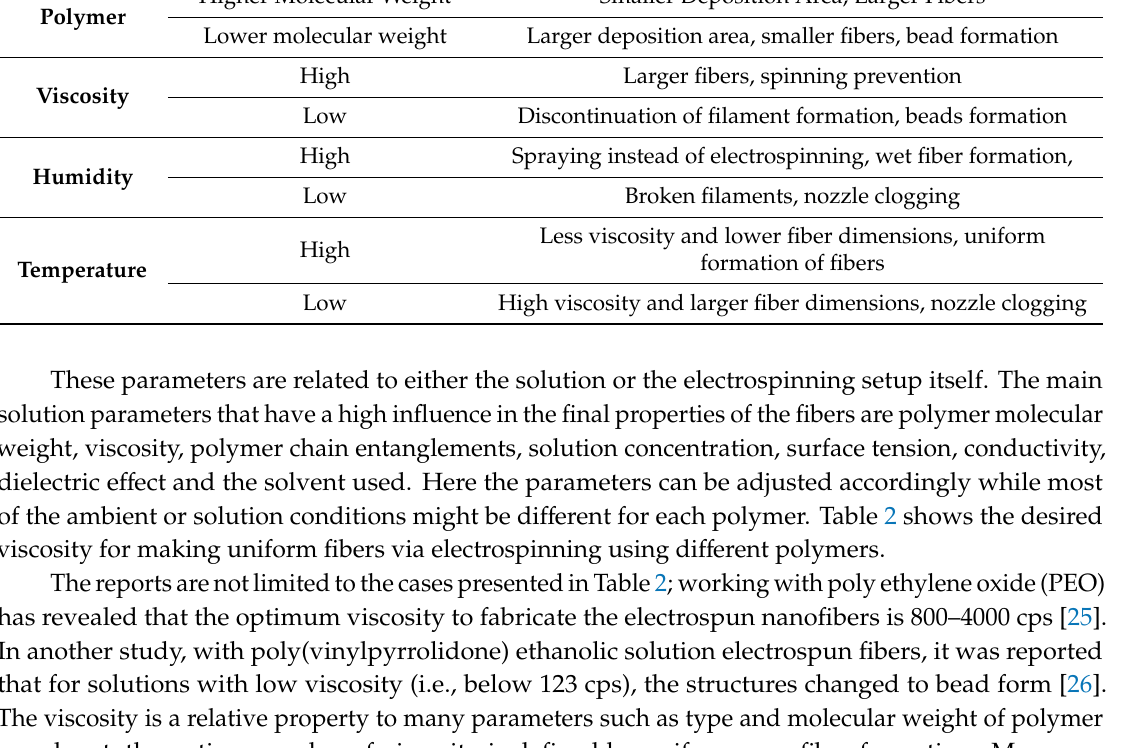
Table 1. E ff ect of electrospinning parameters on filament formation Table 1. Effect of electrospinning parameters on filament formation [2,16] .